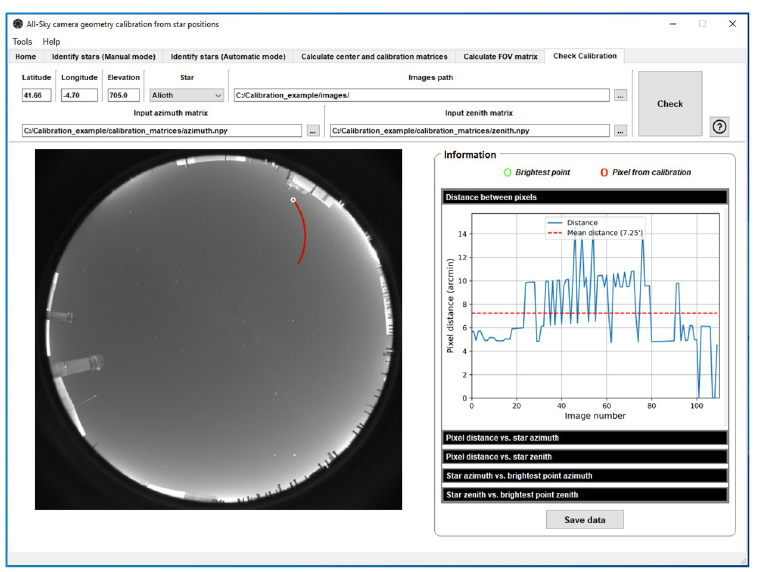
Fig 7. ORION screenshot for checking the calibration feature using the star